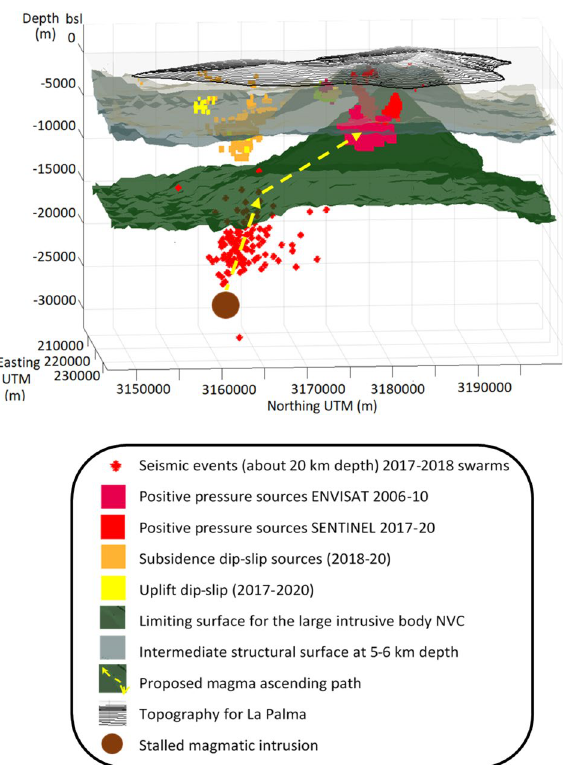
Figure 8. Conceptual model for the unrest evolution. Two main surfaces obtained in the 3D gravimetric crustal model (green and grey surfaces), the modeled positive pressure sources for the periods 2006–2010 and 2017–2020, the modeled dip-slip sources in 2019–2020, and the location of seismic events. The proposed path followed by the magma from depth aseismically (yellow path) before, and probably after, seismic swarms in 2017 and 2018 which may have opened new fractures. See lower inset for a description of the different components of the plot. Matlab software (www.mathw orks.com) was used to create this